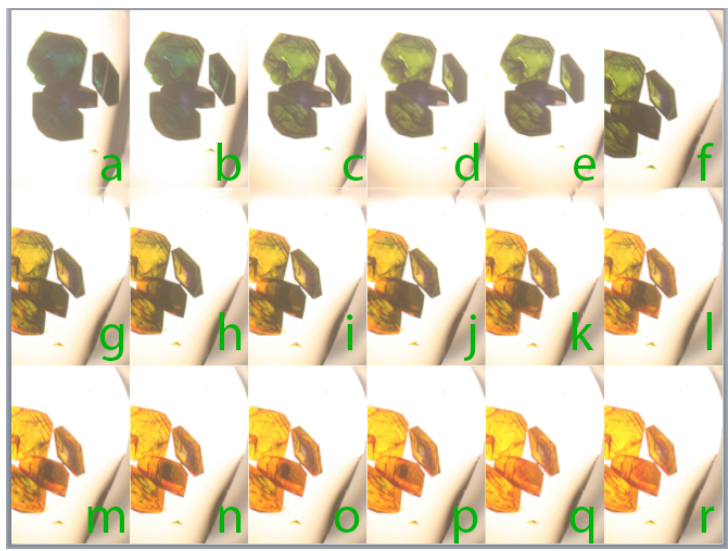
Figure 5. Tetragonal lysozyme crystals saturated with the dye bromocresol green are a dark blue-green color at pH 6.0 in ( a ). When the pH of the mother liquor was altered to pH 3.8, the crystals were seen in ( b ) through ( r ) to change in color to yellow. The series of images ( a – r ), taken at appropriate time intervals, shows the progress of the dye.